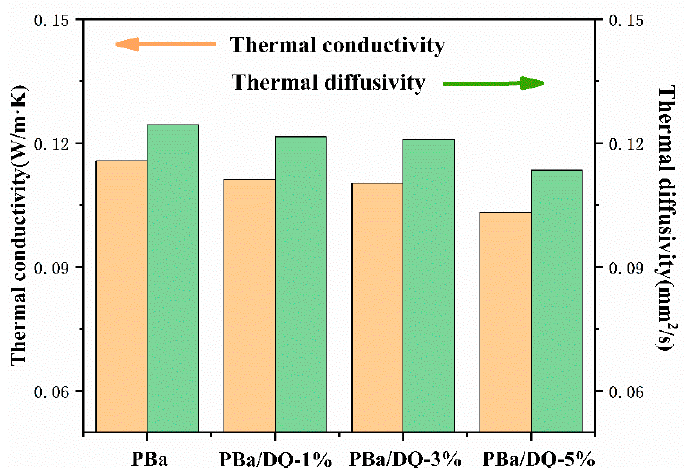
Figure 6. The thermal conductivity and thermal diffusivity of aerogels.